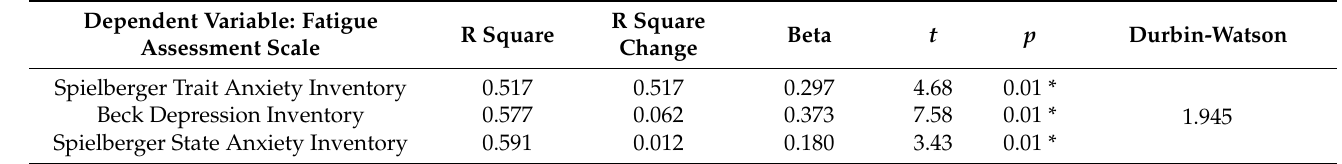
Table 3. Stepwise multiple regression (only statistically significant variables are